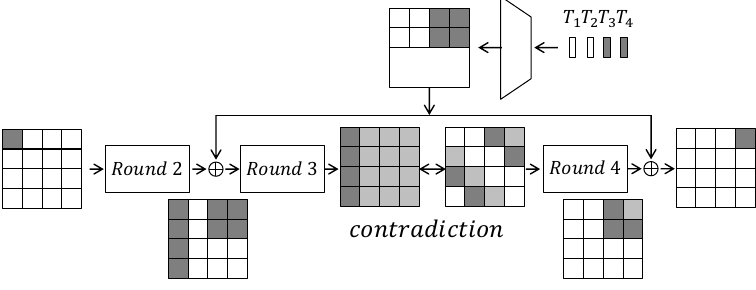
Figure 5: TweAES : 3-Round Impossible Differential with Non-Zero Tweak Difference. For the key recovery, one round and two rounds can be appended to the beginning and the end of the 3-round impossible differential, which is illustrated in Fig. 6.